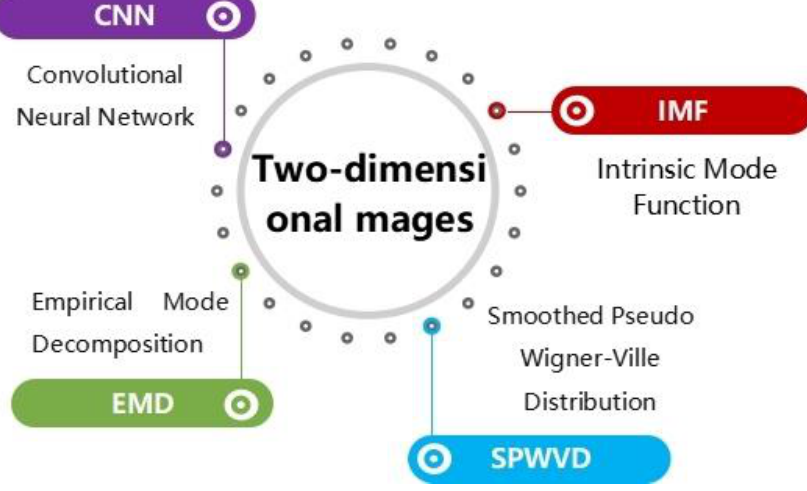
Figure 8. Several common methods of diagnosing bearing faults with two-dimensional images.